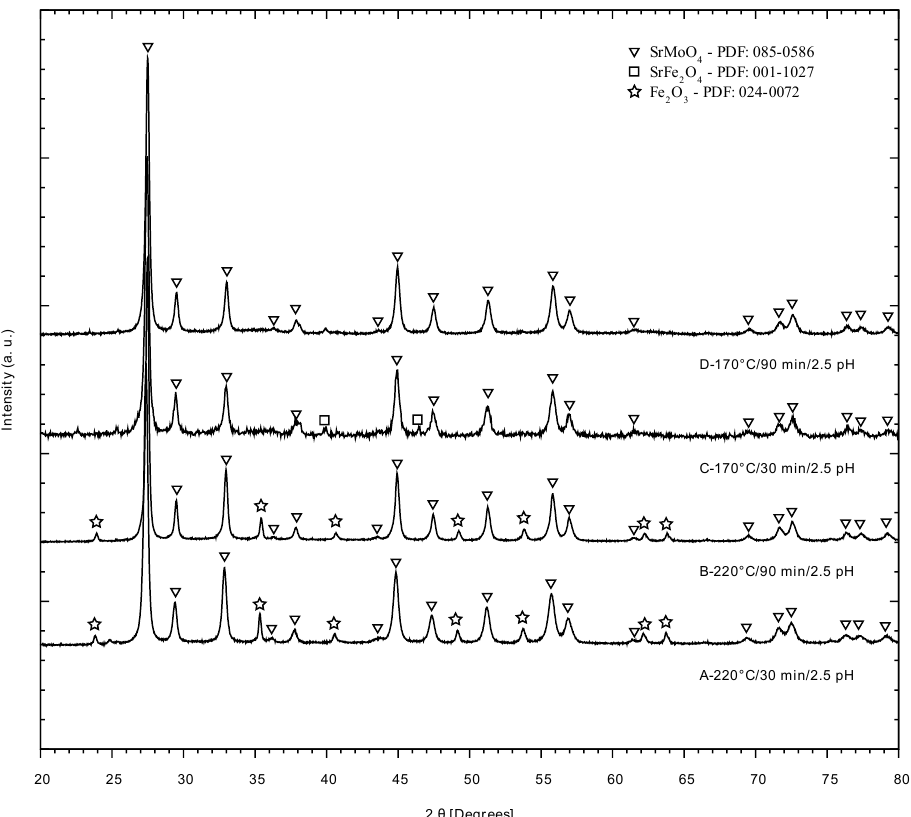
Figure 1. XRD patterns of the solid obtained in experiments A, B, C, and D in which microwave radiation was used. Bragg reflections attributed to main components (SrMoO 4 (PDF: 085-0586) and Hematite, Fe 2 O 3 (PDF: 024-0072)) are highlighted.